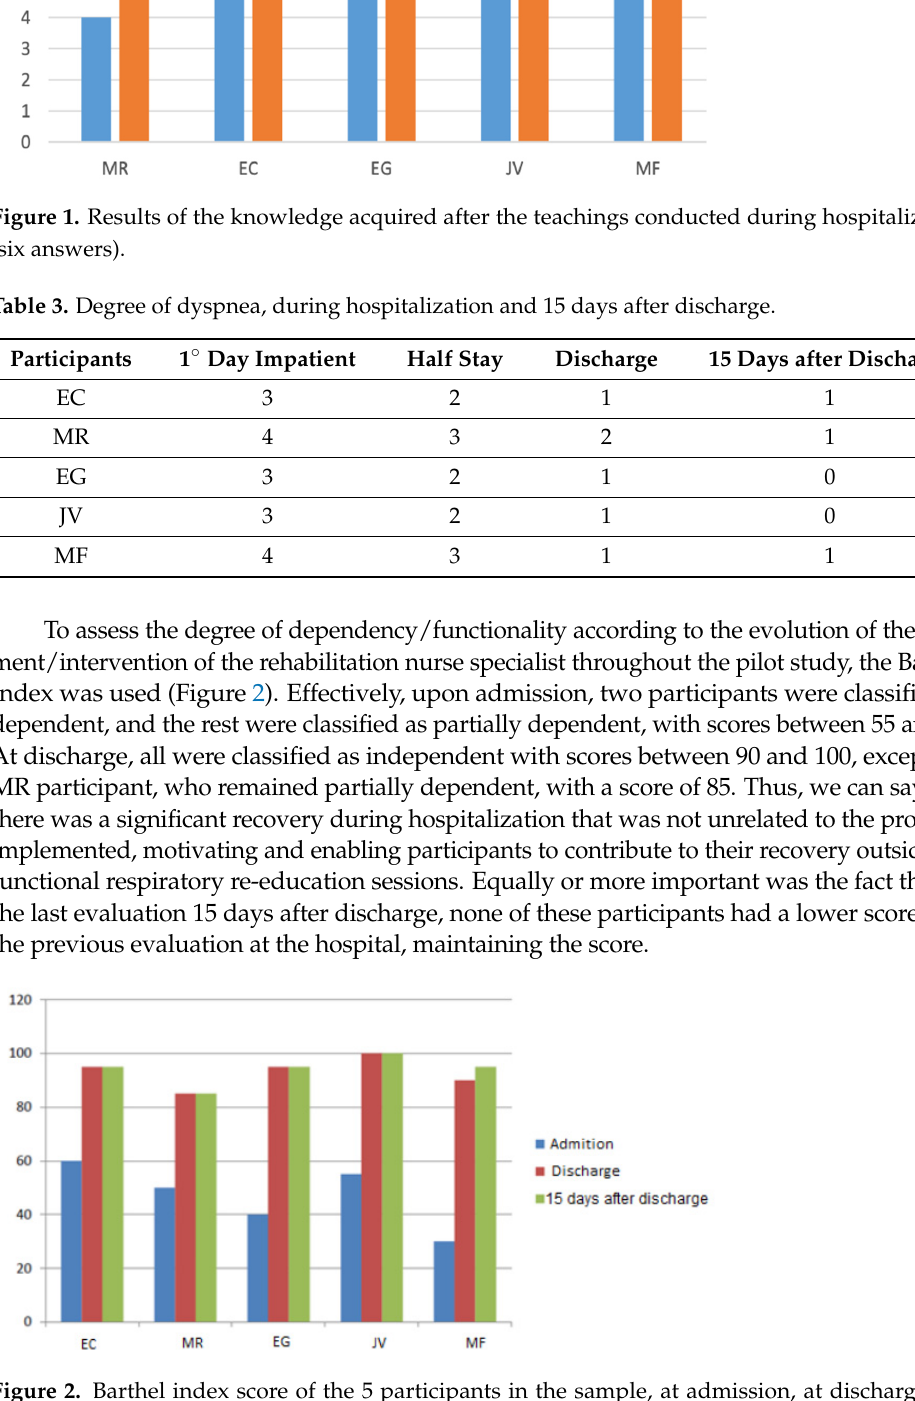
Figure 2. Barthel index score of the 5 participants in the sample, at admission, at discharge and 15 days after